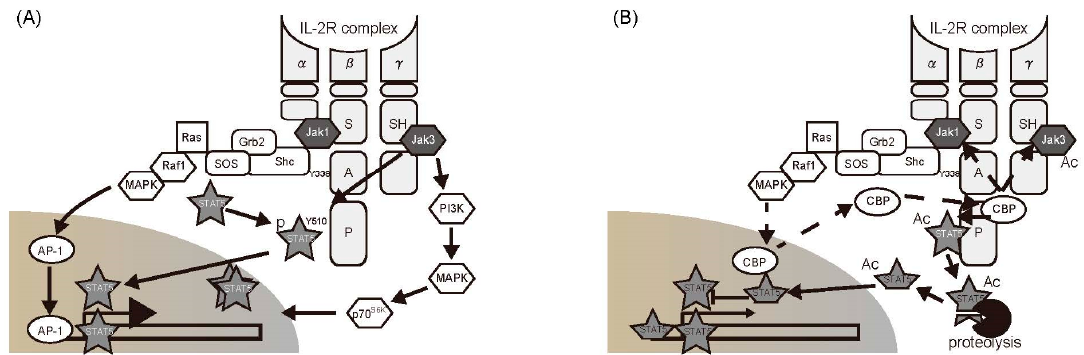
Figure 4. Schematic of IL-2 receptor signaling pathway: ( A ) An IL-2 signal presumably involves the integration of these and other pathway as well. ( B ) CBP-mediated acetylation of STAT5 negatively regulates IL-2 receptor signaling.